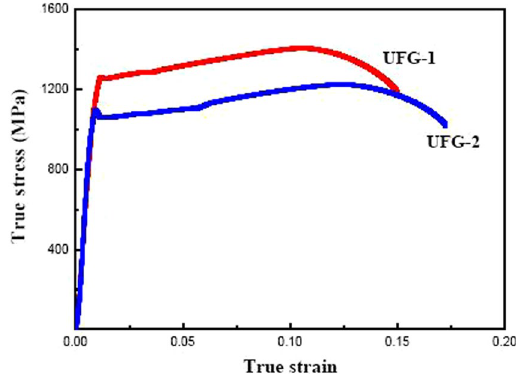
Figure 5. True stress-strain curves for UFG-1 and UFG-2 steels tensile tested at